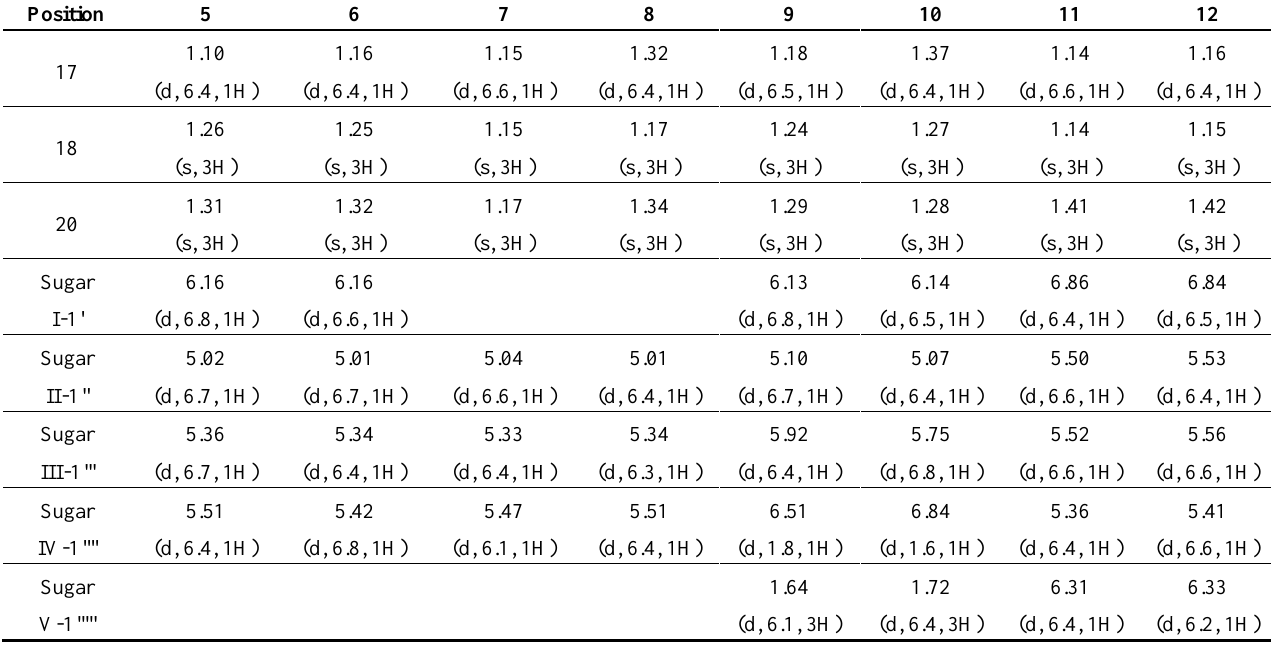
Table 7. 1 H NMR chemical shifts values for reduced compounds 5 – 12 recorded in pyridine-d5 (C D N) a – c . 5 5